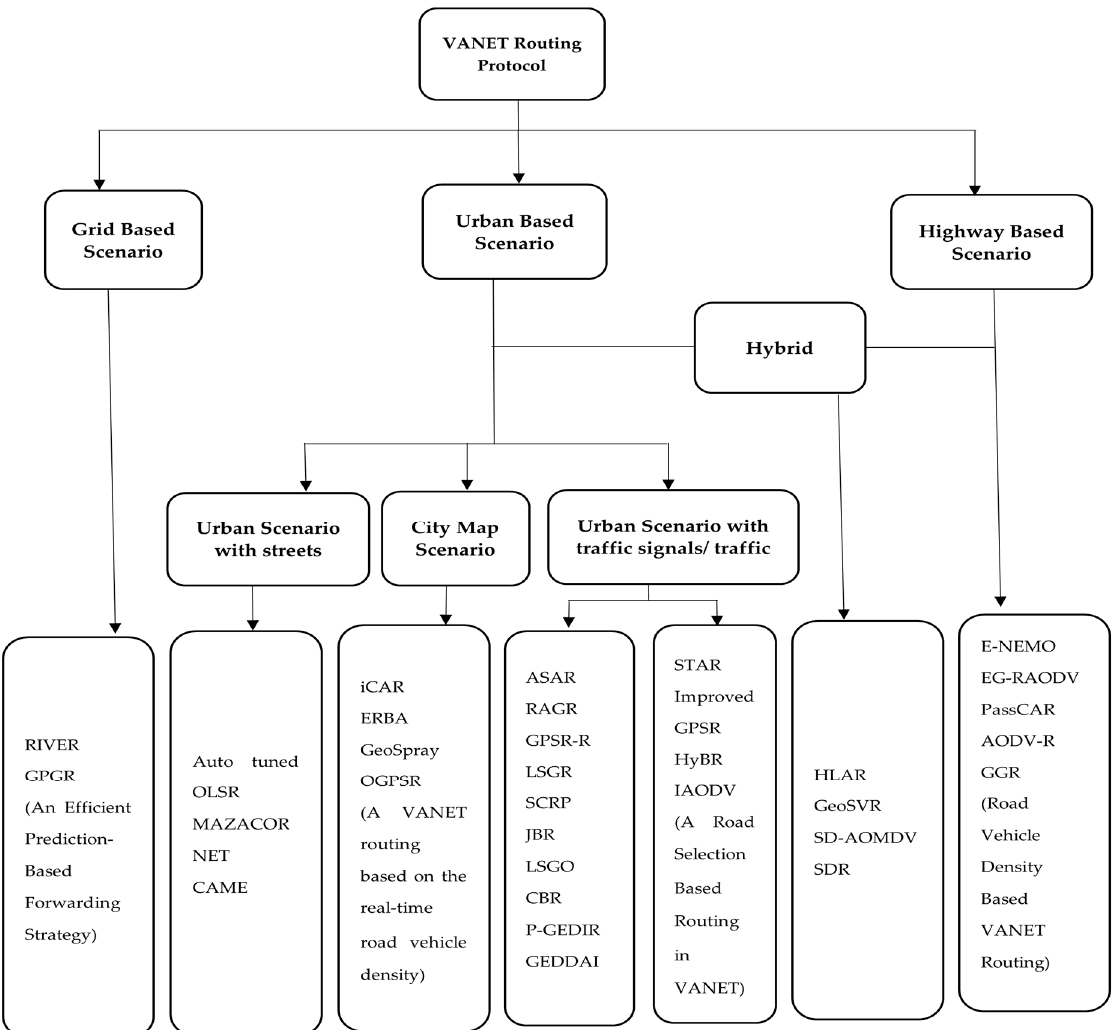
Figure 5. Taxonomy of VANETs routing protocols.